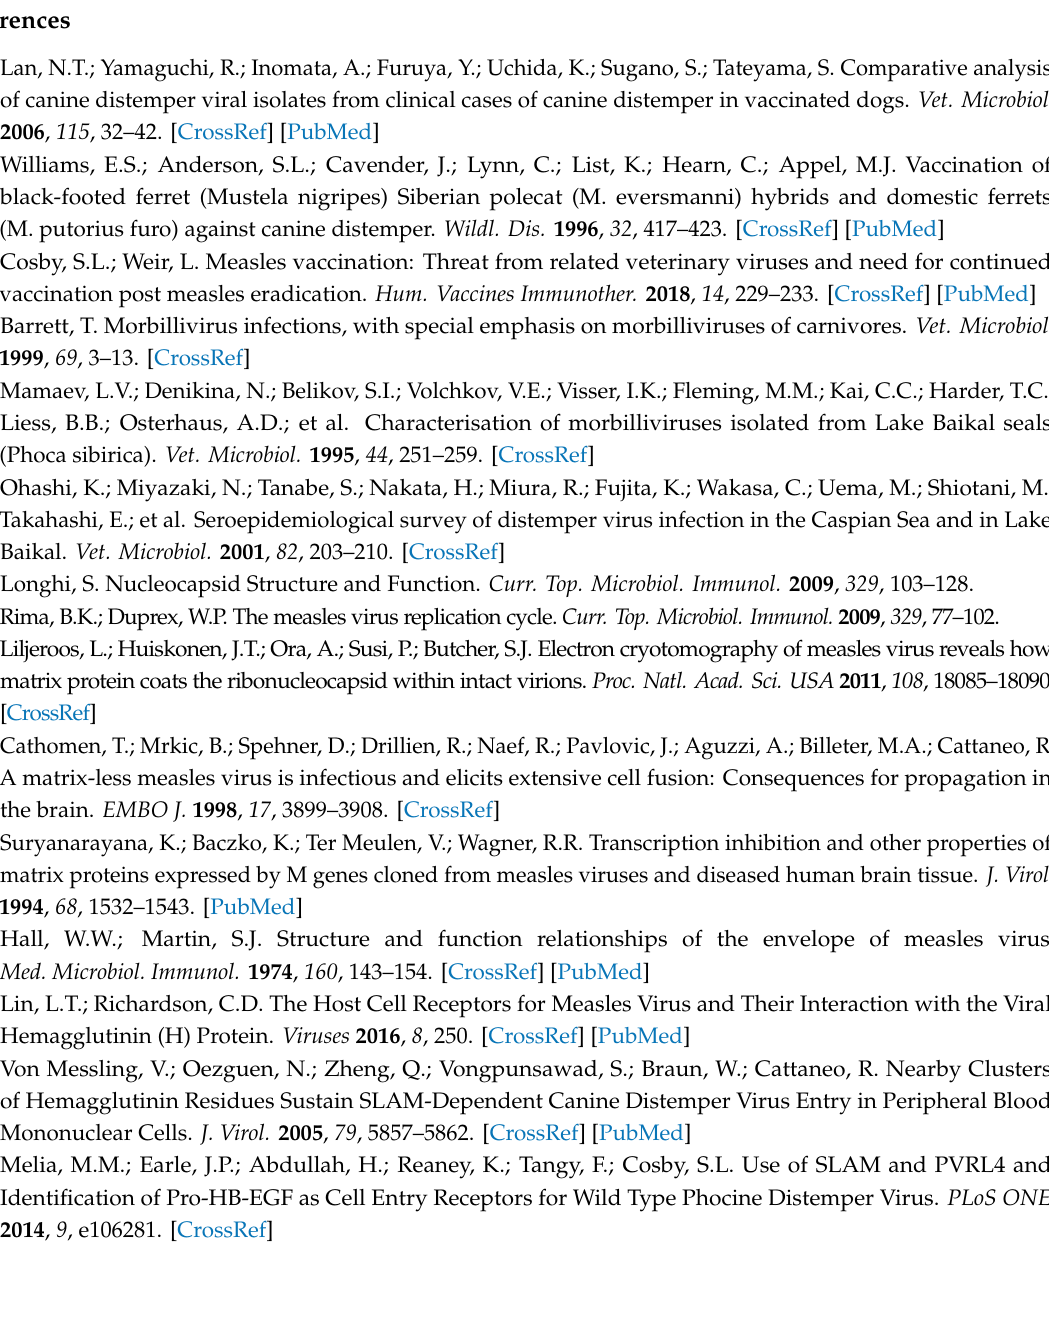
Figure S1: Alignment of CDV P / V amino acid sequences 1 to 250 for selected viruses, Figure S2: Alignment of CDV C amino acid sequences, Figure S3: Alignment of CDV H amino acid